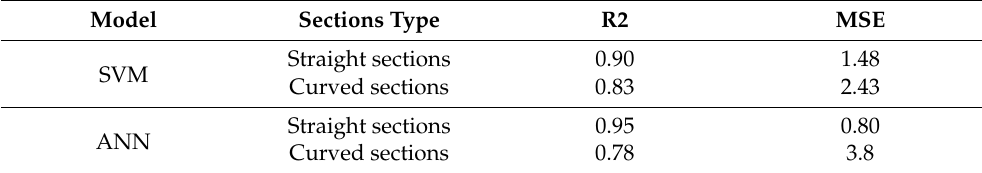
Table 7. Results of SVM and ANN for prediction of straight and curved sections. Adapted from [97].